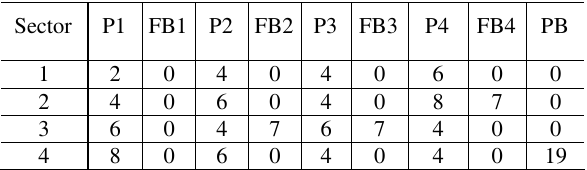
Fig 5. Cyclogram with critical path (course 2) (Units, Process 4, …, Sectors)